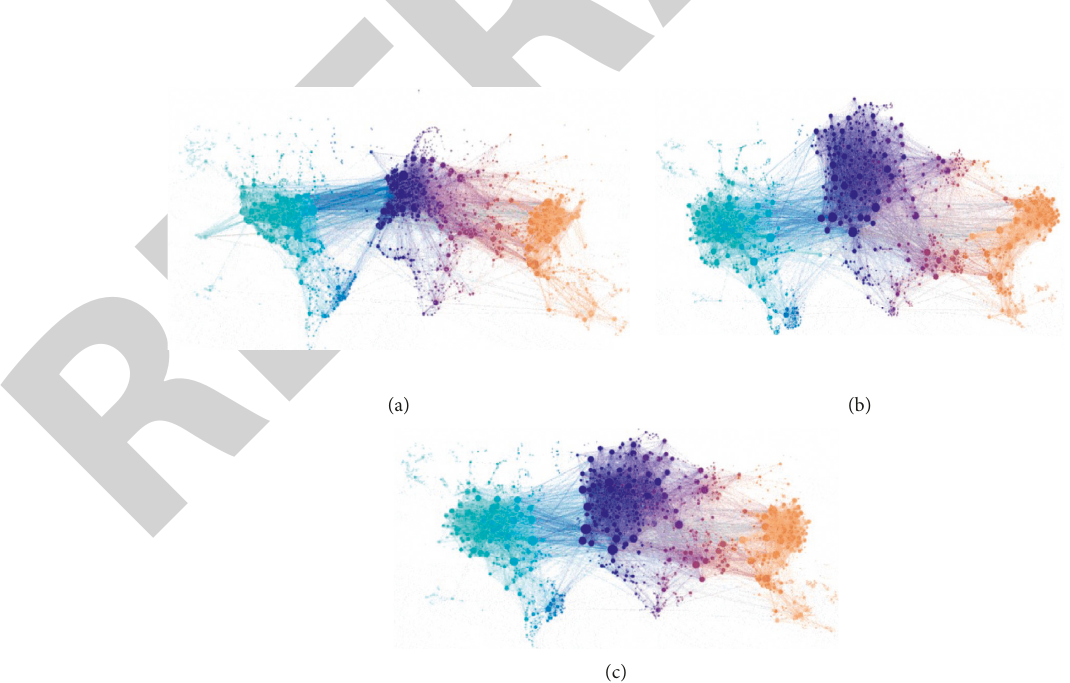
Figure 10: Dynamic simulation of civil aviation airport traffic. (a) Time 1. (b) Time 2. (c) Time